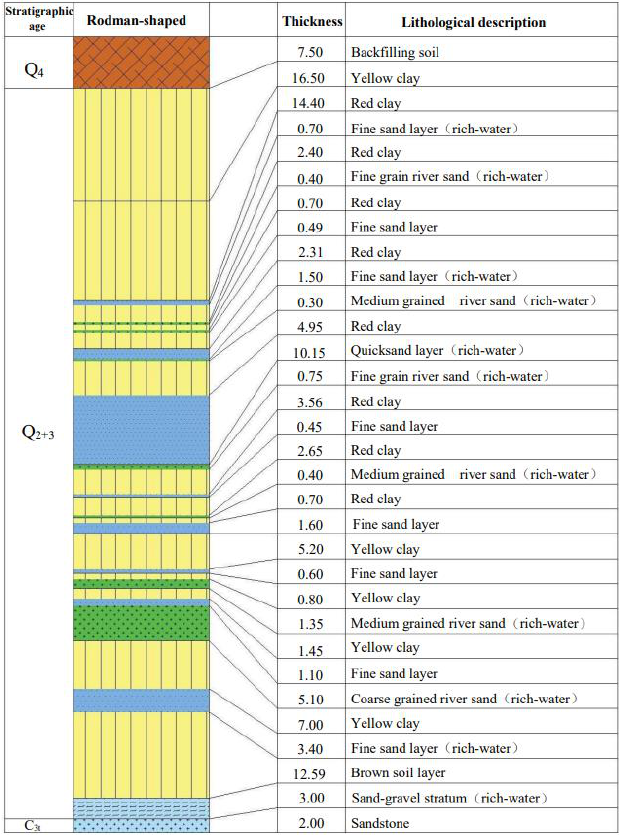
Figure 3. Cenozoic stratigraphic column of the auxiliary shaft.